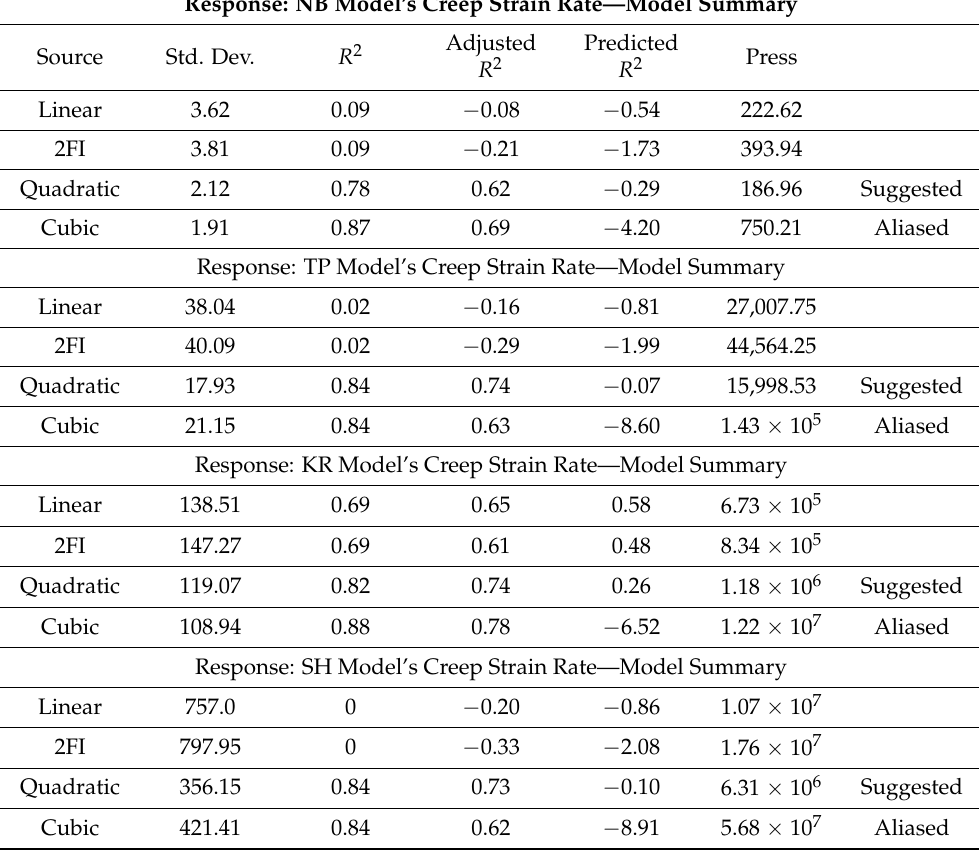
Table 7. Summary of the